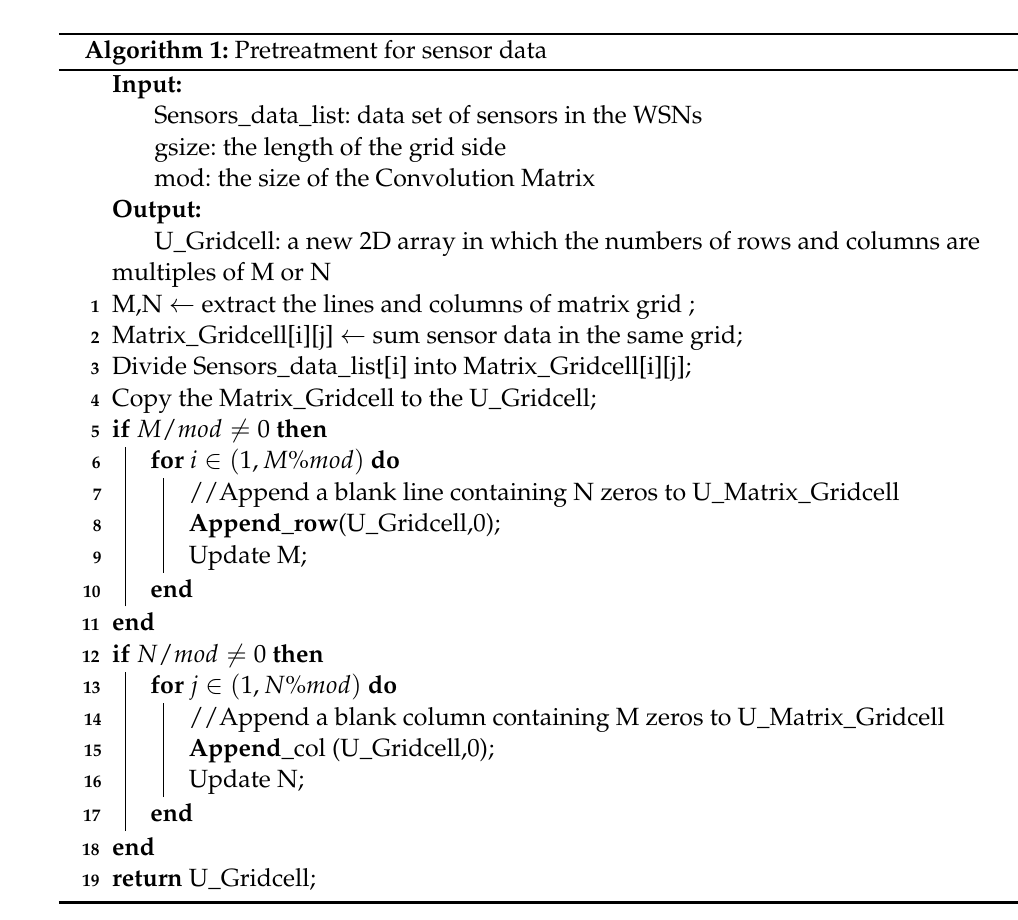
Algorithm 2: Convolution-based Continuous Objection